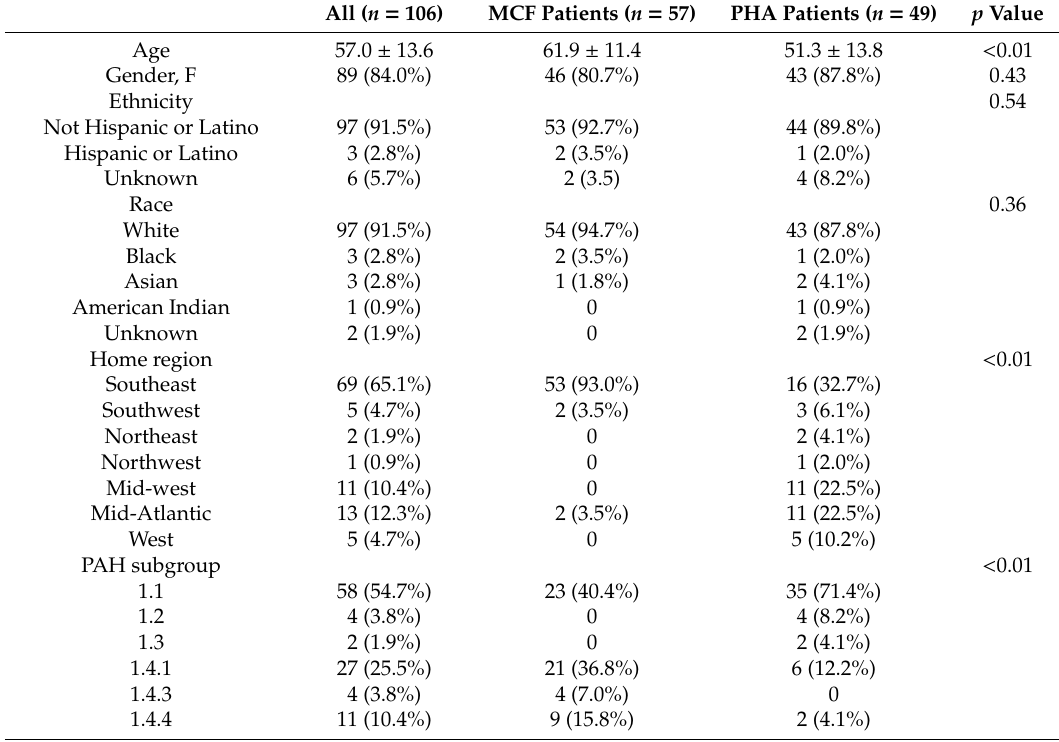
Table 1. Patient demographics of the entire cohort and then separated into groups.